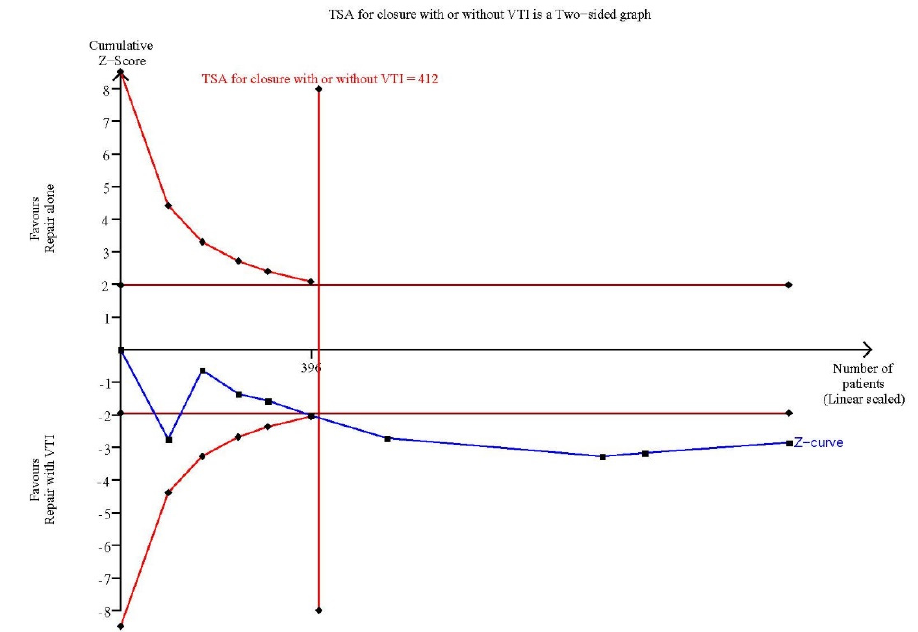
Figure 6. Trial sequential analysis (TSA) of overall effect of palatal repair with VTI.